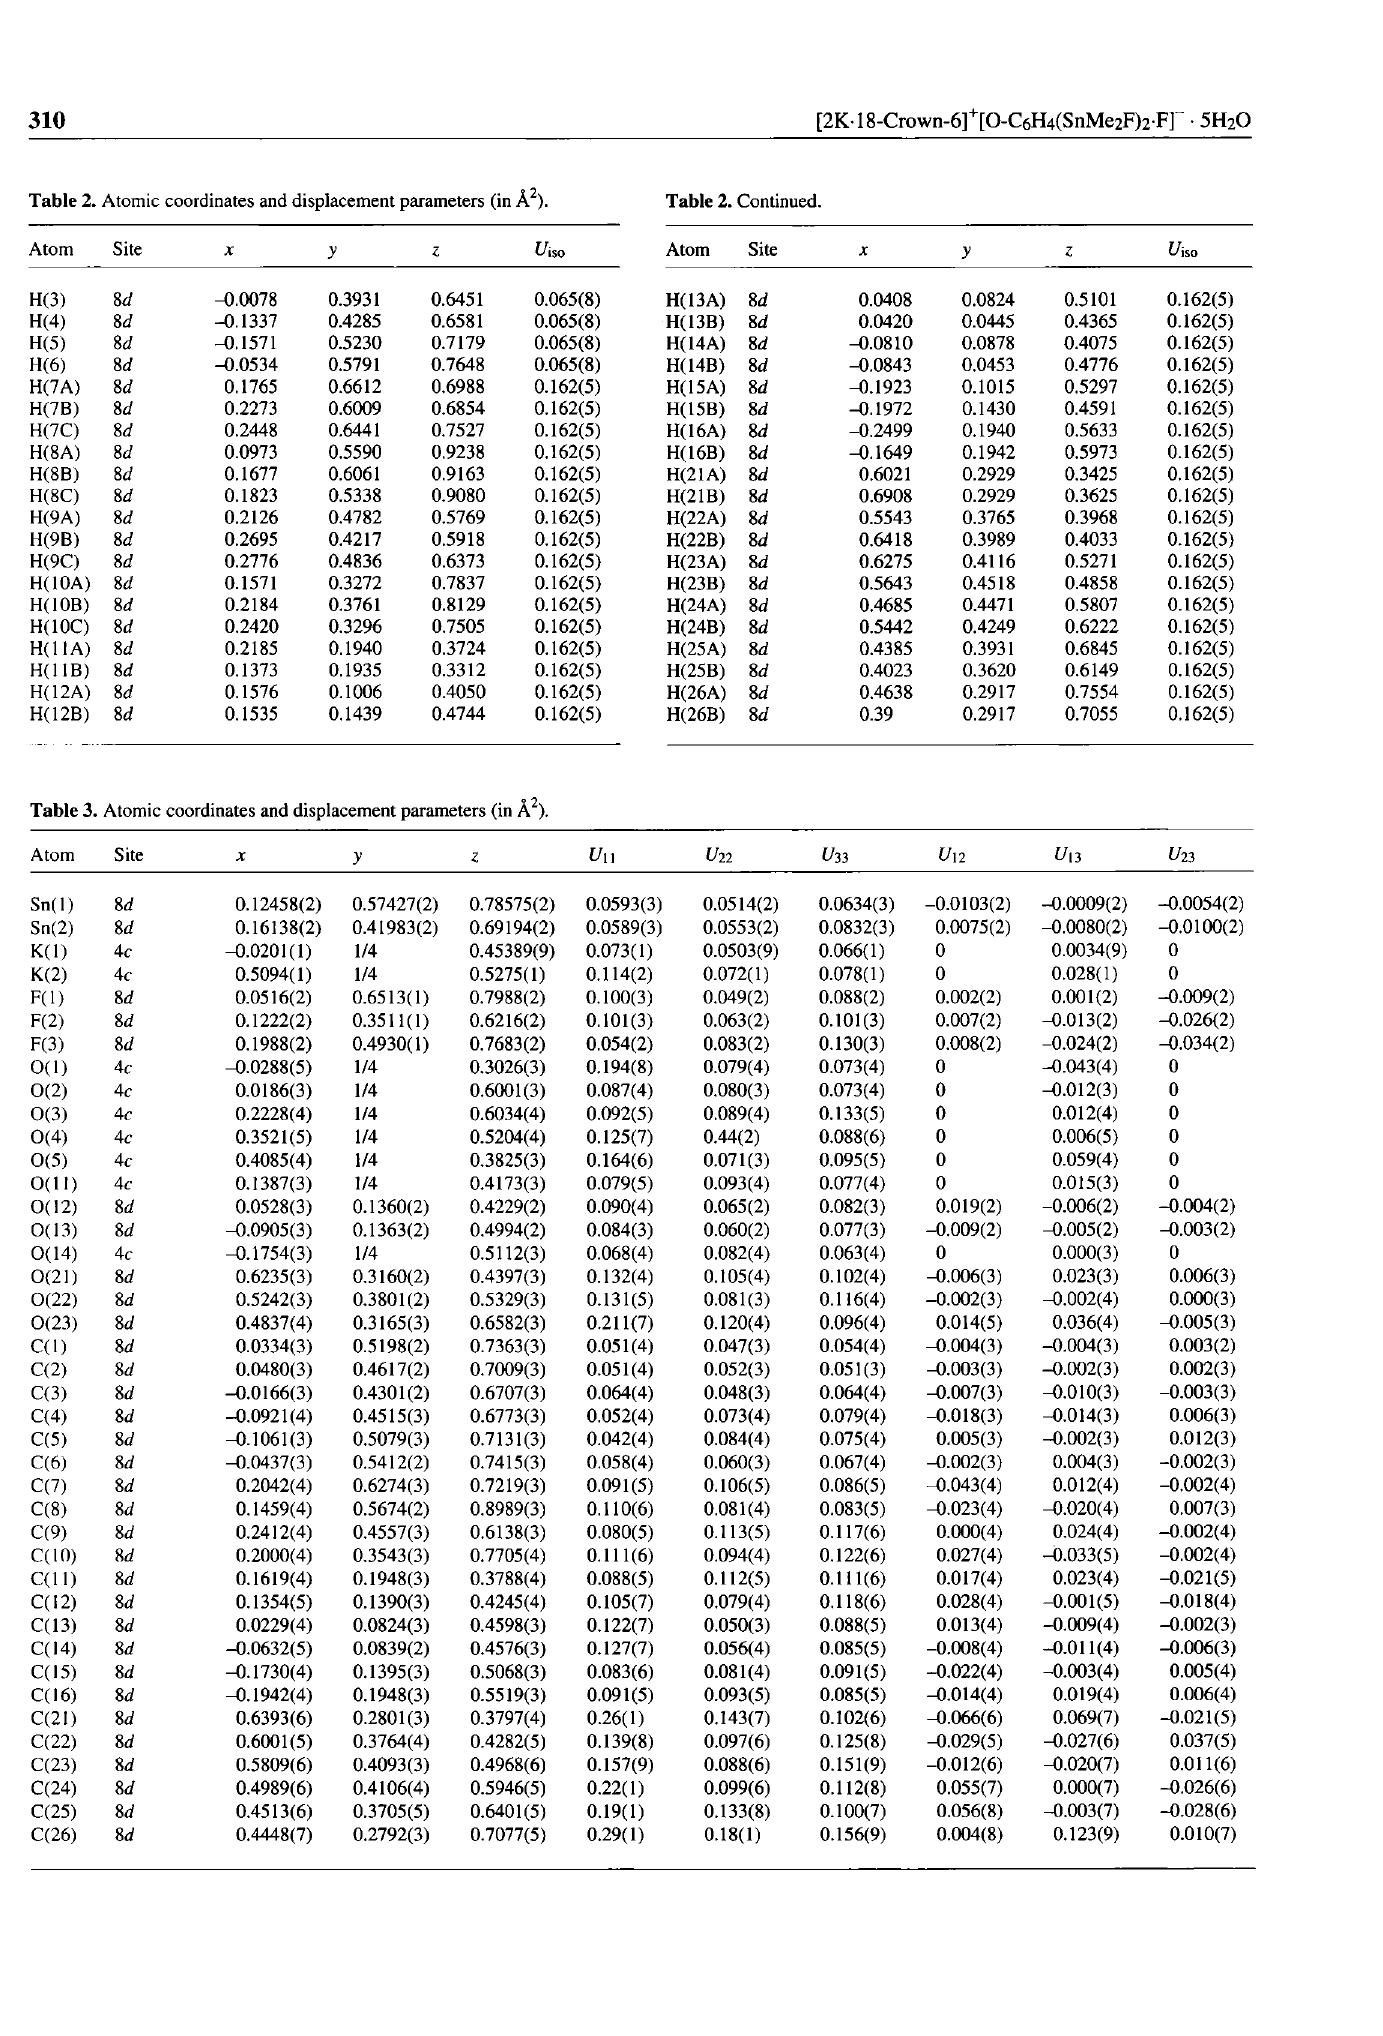
Table 3. Atomic coordinates and displacement parameters (in Ä 2